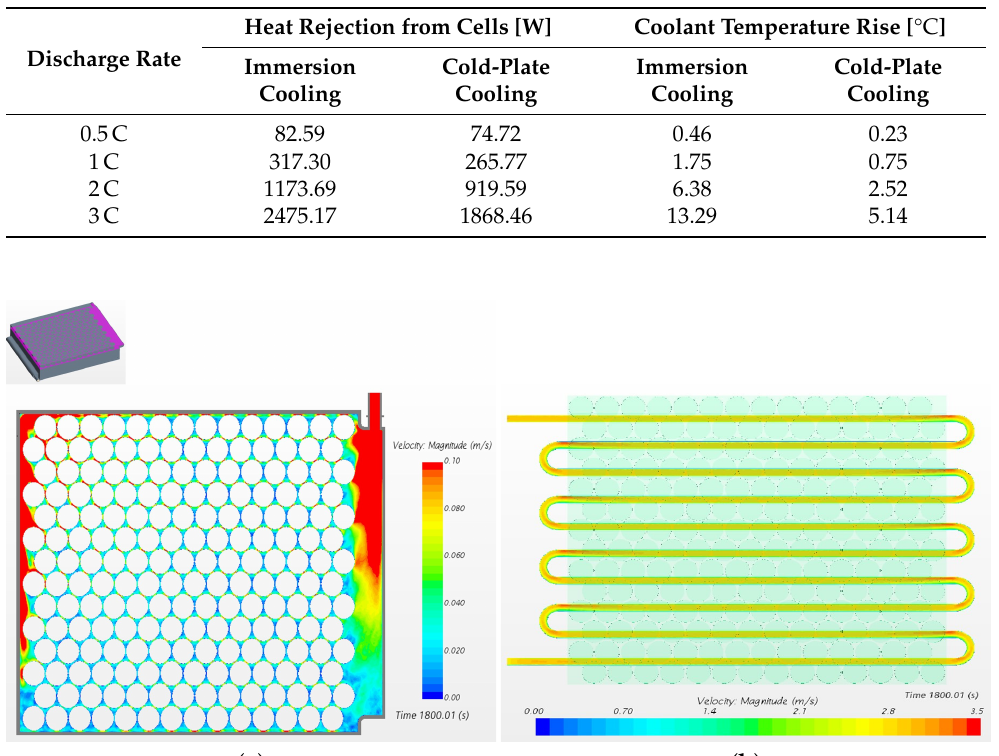
Table 9. Variation of heat rejection to the coolant and coolant temperature rise at the end of discharge at different module discharge rates.